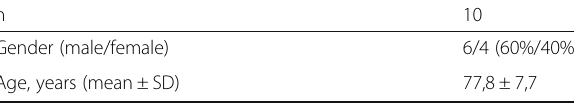
Table 3 T-cell samples: Healthy controls